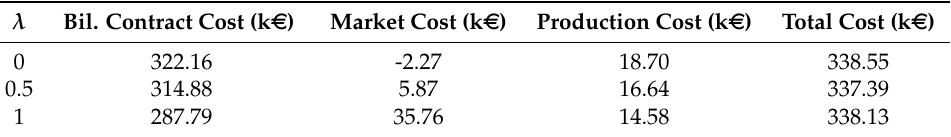
Table 3. Out-of-sample analysis ( α =